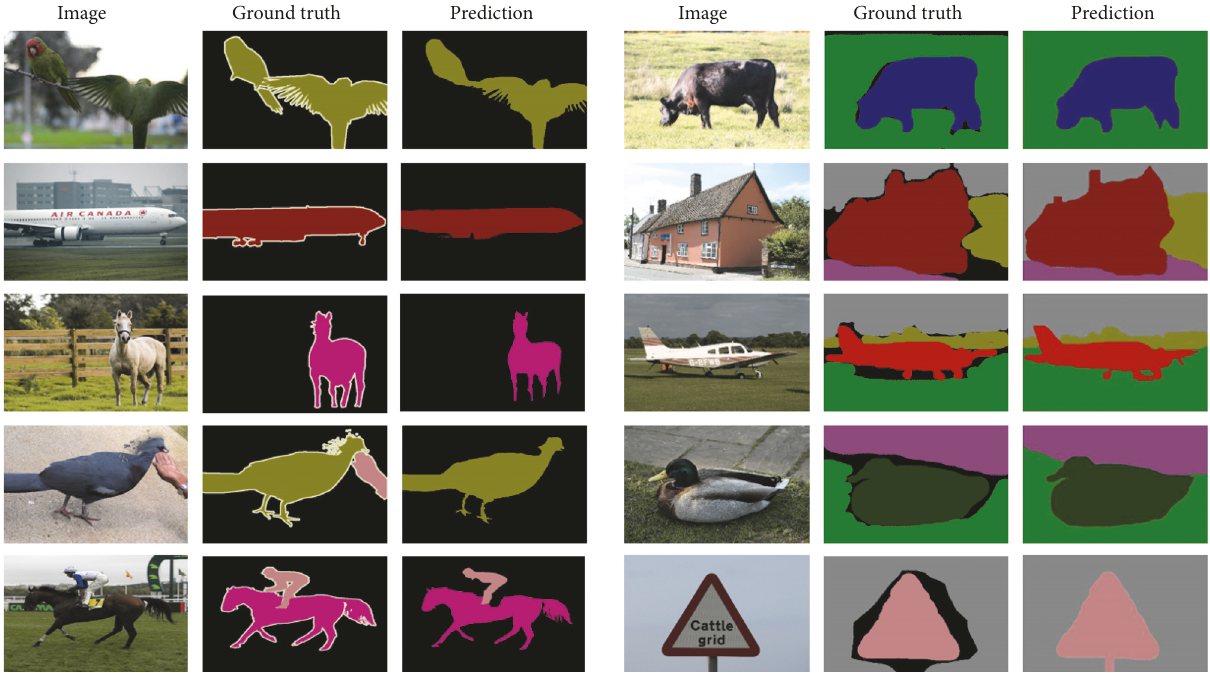
Figure 6: Examples of predicted segmentations (the left are the examples of MSRC and the right are the examples of PASCAL VOC 2012